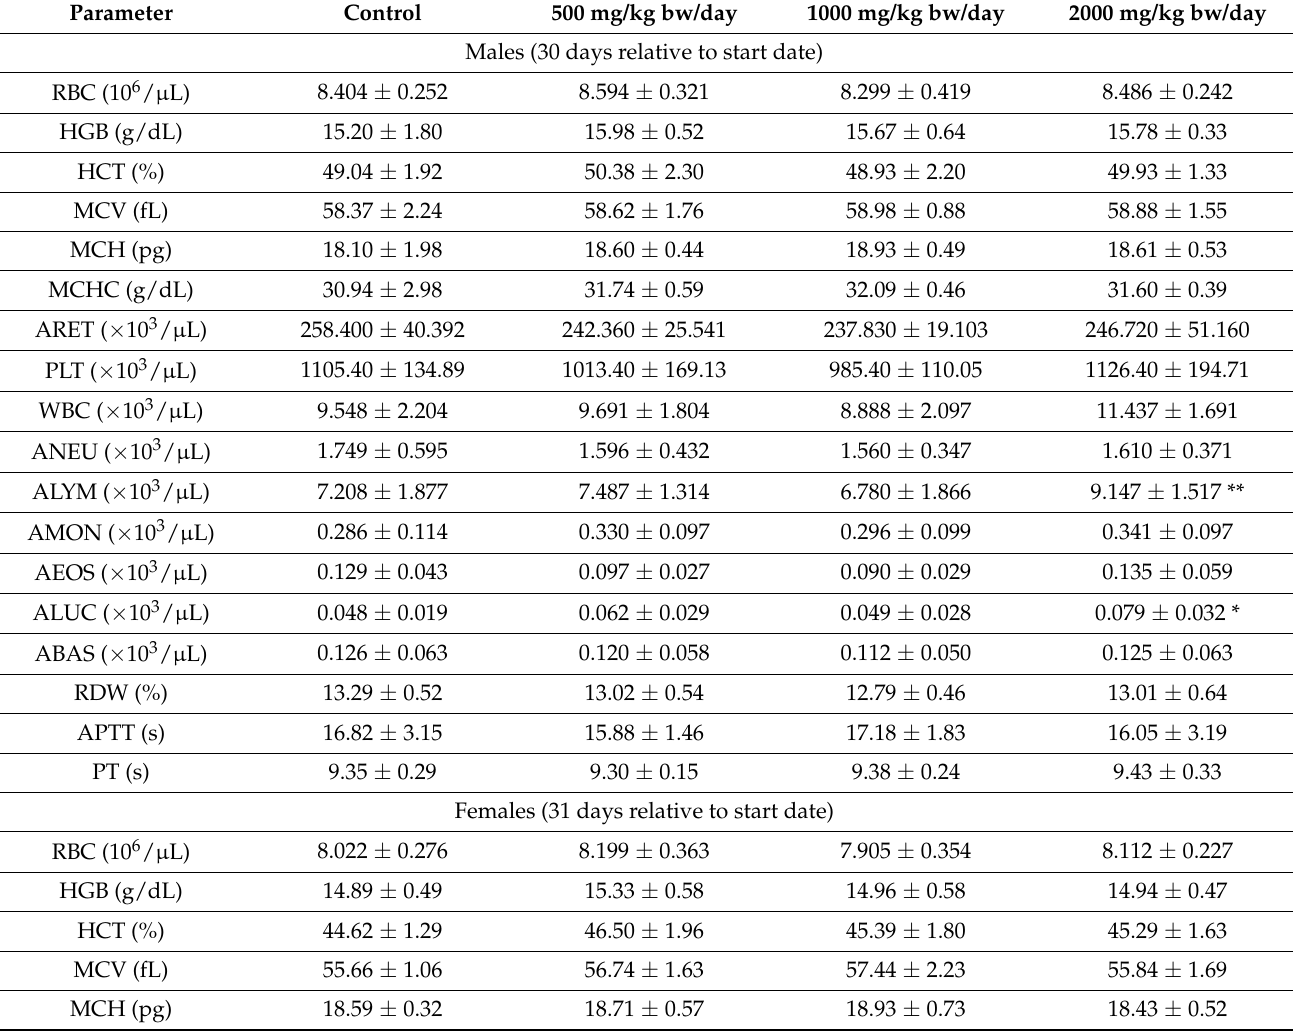
Table 4. Hematology and coagulation data for the 28-day repeat dose oral toxicity study with